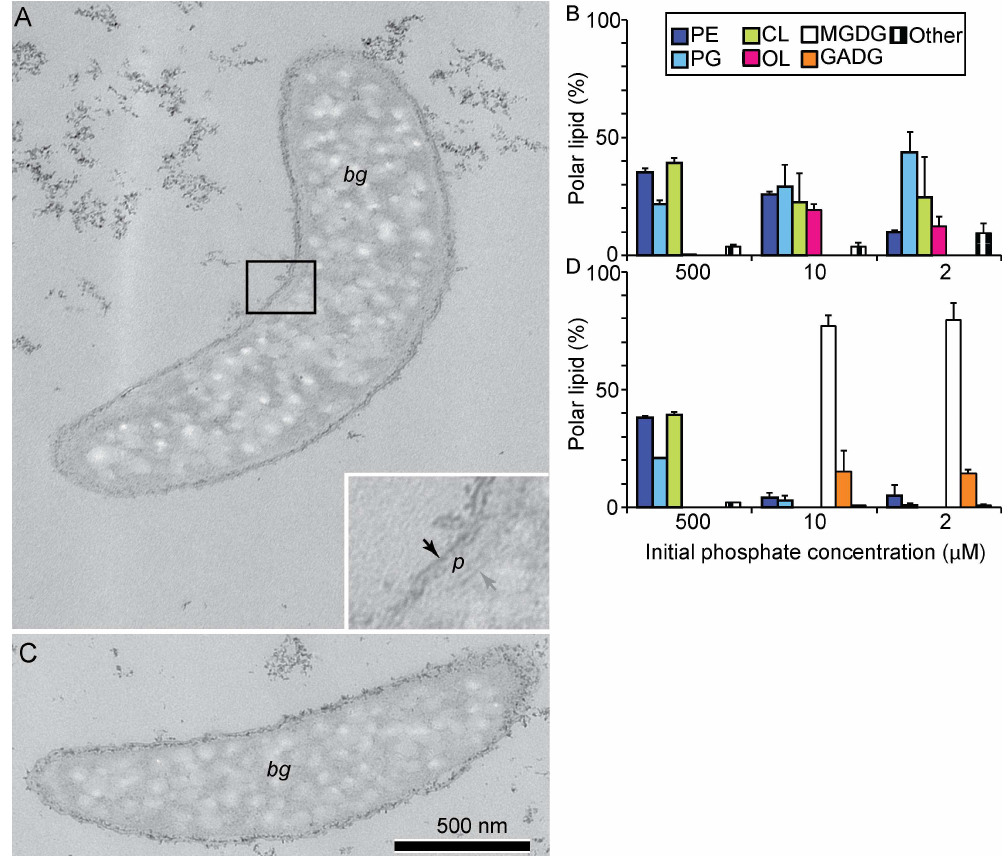
Fig 5. The ultrastructure and composition of polar lipids of Dde_3613( Δ agt ) and Dde_3661( Δ olsF ). (A) Representative TEM of the Dde_3613mutant. Bm marks a representative area filled with bright material. Black arrows point to the inner and outer membranes, p indicatesthe periplasm.(B) Polar lipid compositionof the Dde_3613mutant grown at different initial phosphateconcentrations. (C) Representative TEM of the Dde_3661 mutant. Bm marks a representative area filled with bright material. (D) Polar lipid composition of the Dde_3661 mutant grown at different initial phosphate concentrations. (A) and (C) are shown on the same scale shown by the scale bar in panel (C). Abbreviations for the polar head groups: PE is phosphatidylethanolamine, PG is phosphatidylglycerol, CL is cardiolipin,OL is ornithinelipids, MGDG is monoglycosyl diacylglycerol, GADG is glycuronic acid diacylglycerol. Other lipidsincludeN-acyl-PE and N-acetyl-PEand two unidentifiedlipids with head group losses of 199 Da and 213